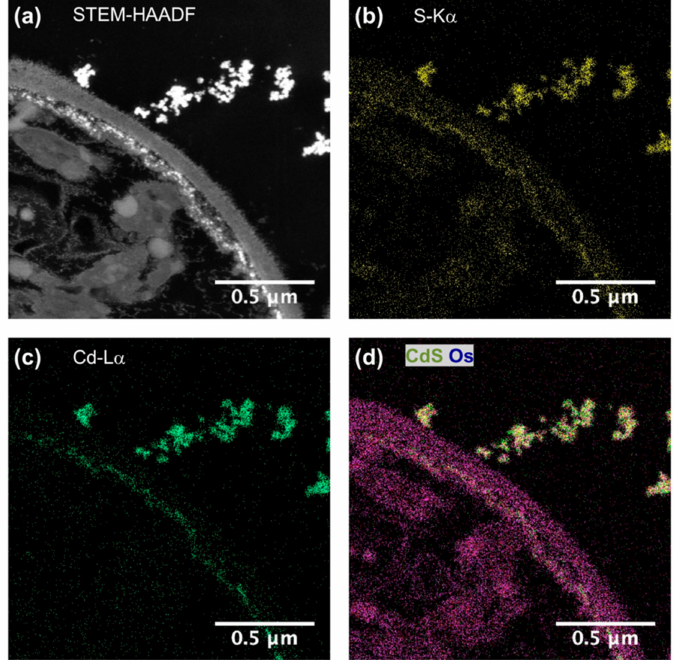
Figure 9. ( a ) STEM-HAADF and ( b – d ) STEM-XEDS images of Chlorella vulgaris ultrastructure after contact with CdS–1 nanoparticles (10 –3 M) in Seine